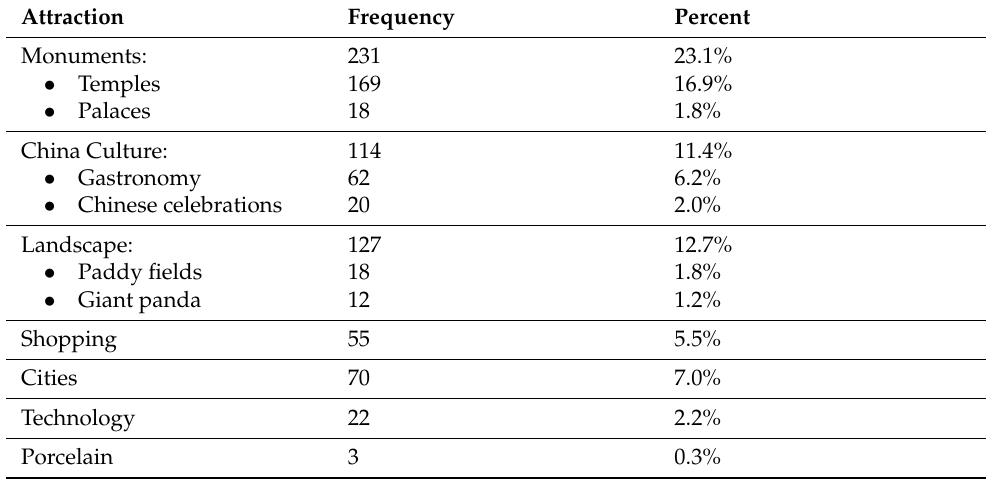
Table 5. Generic attractions